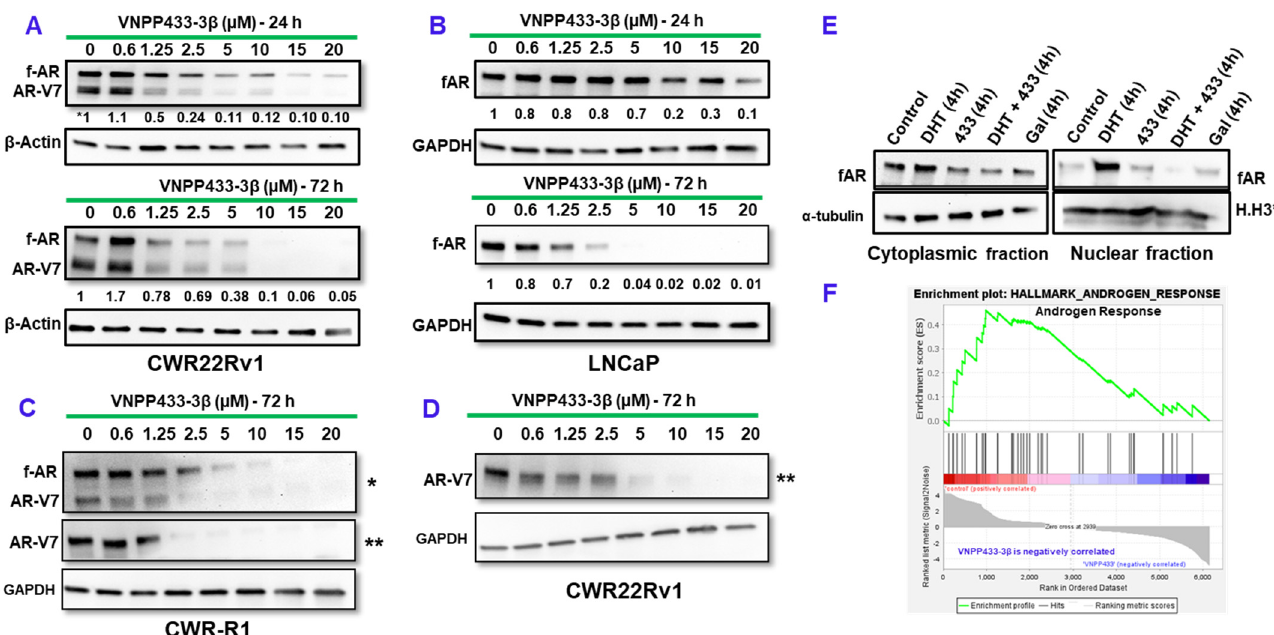
Figure 1. VNPP433-3 β causes degradation of f-AR in a concentration-dependent manner. ( A – D ) Immunoblots of f-AR and AR-V7 following treatment with varying concentrations of VNPP433-3 β (433) for 24 or 72 h in CWR22Rv1, LNCaP and CWR-R1 cells. * Probed with f-AR antibody and ** AR-V7-specific antibody. GAPDH or β -actin served as loading control. ( E ) Nuclear translocation of f-AR is inhibited by VNPP433-3 β (433). 22Rv1 cells were treated with the androgen dihydrotestosterone (DHT), VNPP433-3 β (433) or Gal (parental compound) for 4 h. DMSO served as control. The cells were harvested, and nuclei isolated. The cytoplasmic and nuclear fractions were immunoblotted for f-AR. α -tubulin served as cytoplasmic loading control and Histone H3 (H.H3*) as nuclear loading control. Nuclear translocation assay was optimized for treatment duration (4 h) to avoid significant degradation of f-AR by VNPP433-3 β (433). ( F ) RNA sequencing and subsequent GSEA plot of the VNPP433-3 β (433)-treated CWR22Rv1 cells show inhibition of androgen response. The uncropped blots are shown in Figure S1.